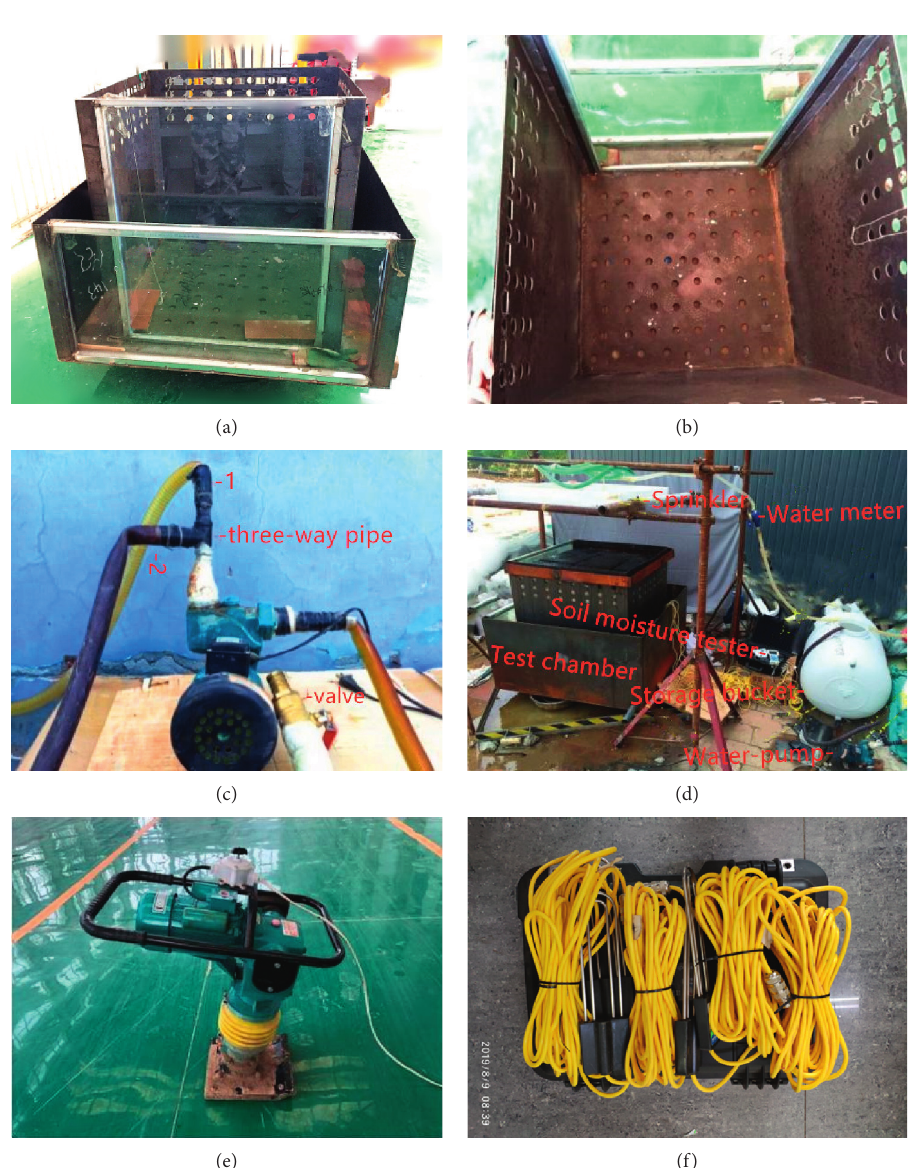
Figure 6: Artificial rainfall experiment device, (a) test chamber, (b) the bottom of test chamber, (c) pump, (d) rainfall equipment, (e) impact tamping, and (f) moisture